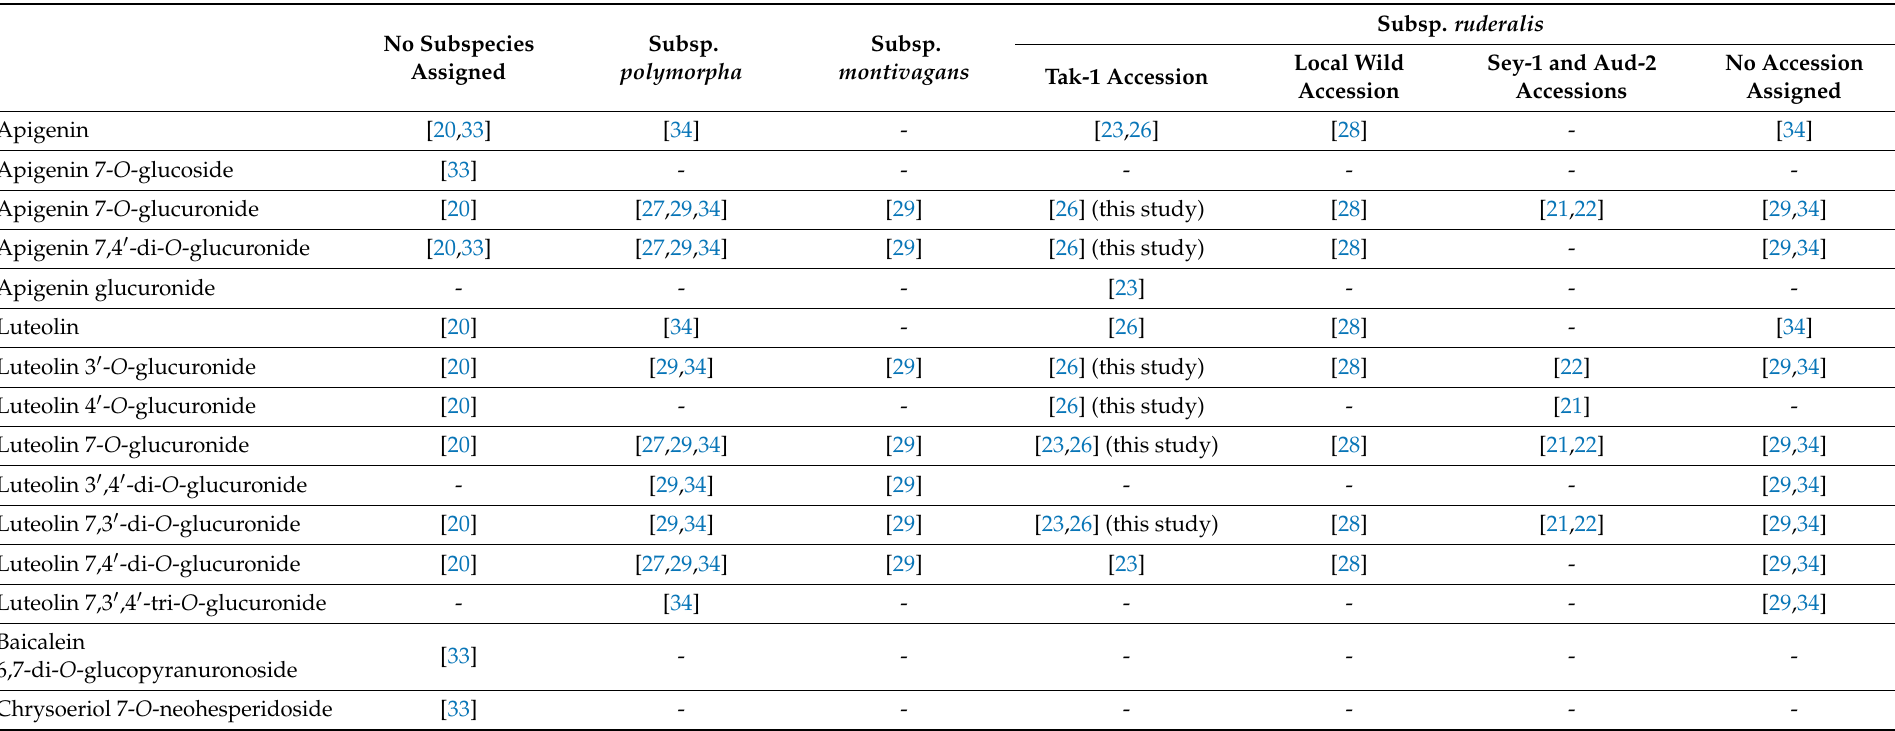
Table 2. Literature references where flavones of the three currently recognized subspecies of Marchantia polymorpha L. (subsp. polymorpha , subsp. montivagans Bischl. & Boissel.-Dub., and subsp. ruderalis Bischl. and Boissel.-Dub.) were found, differentiating the three investigated accessions of M. polymorpha subsp. ruderalis (Tak-1, a local Spanish wild accession, and Sey-1 and Aud-2 accessions). In some cases, the samples analyzed were not assigned to any subspecies or accession. To facilitate comparison with previous literature, old synonyms of M. polymorpha subspecies are provided 1